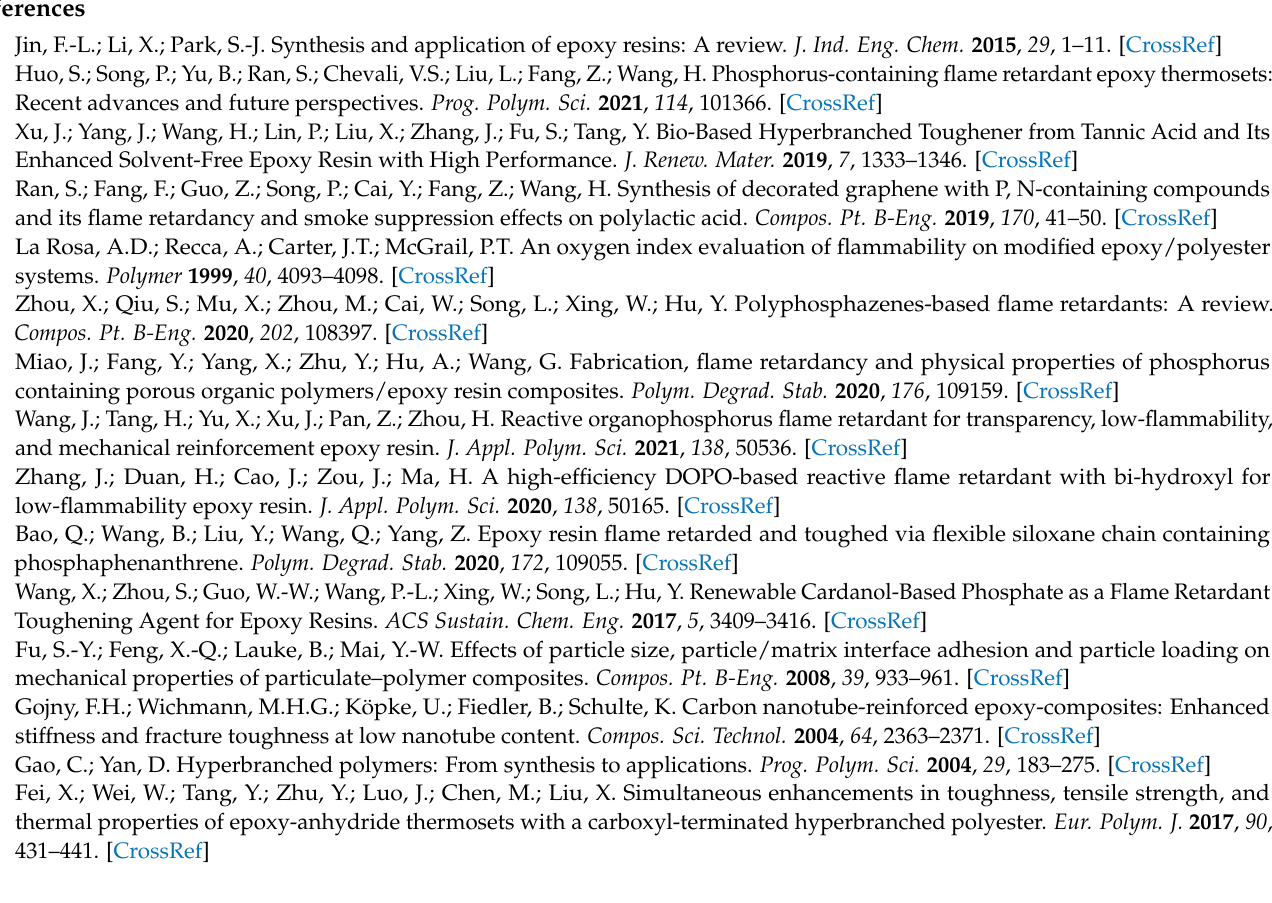
Table S1: UL-94 vertical burning and LOI results of epoxy